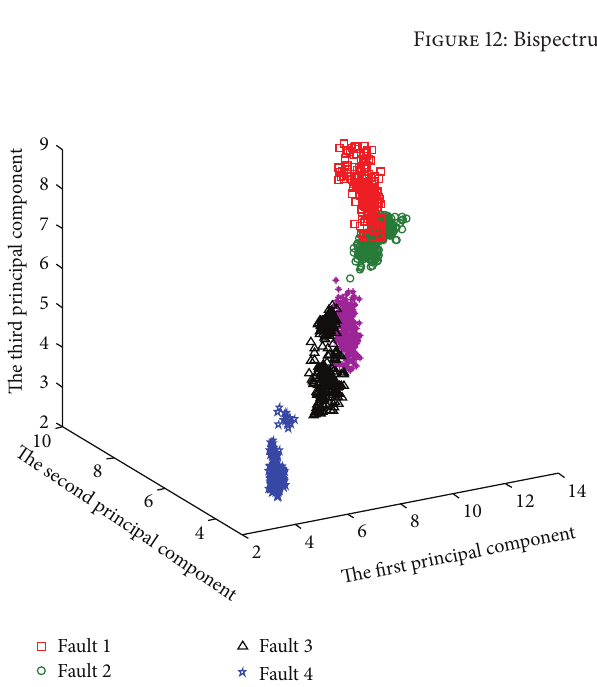
Figure 13: The first three features extracted using